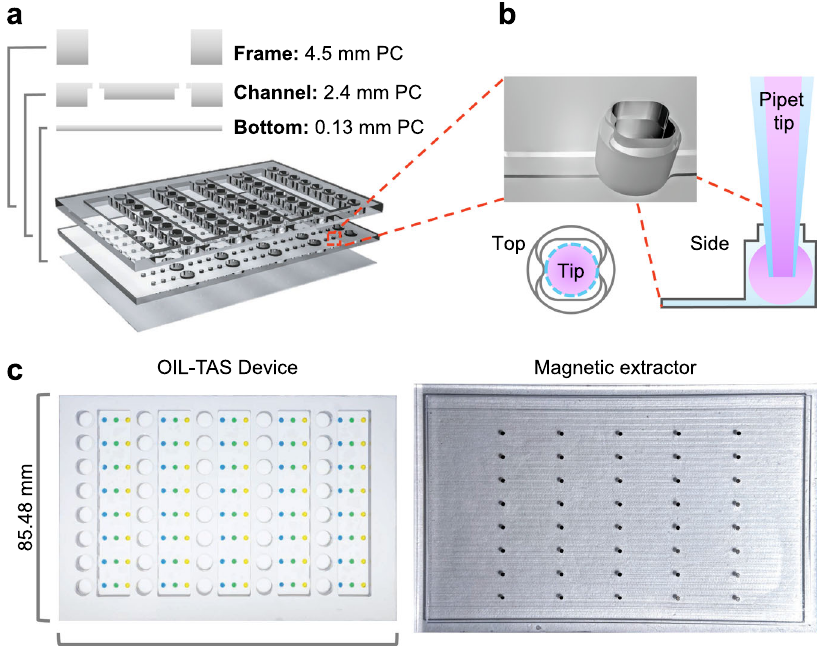
Fig. 2 Design and assembly of the OIL-TAS device. a Exploded view of the OIL-TAS device consisting of three layers fabricated from polycarbonate (PC). b Design of well collar for pipet tip alignment and preventing droplet escape. c Images of the OIL-TAS device (left) and magnetic extractor (right). Food coloring was added to the wells to facilitate rocking platform shaker at 30 rpm for 30 min (Supplementary Fig. 3 and Supplementary Movie 3) or even after vigorous shaking